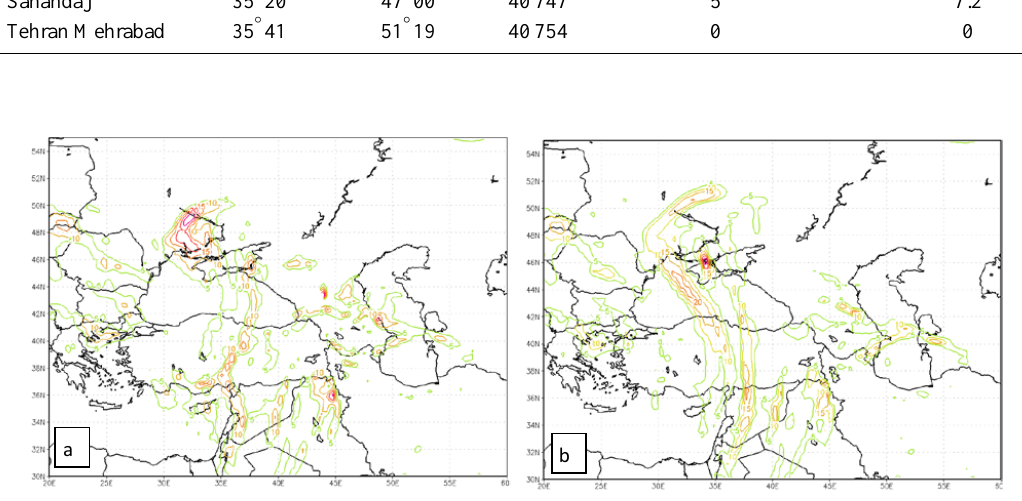
Fig. 5. Forecasts of 700hPa relative vorticity (s − 1 × 10 5 ) for 14 March 2009 at 00:00 UTC for (a) CTL and (b) EXP. Fig.5.Forecasts of 700 hPa relative vorticity ( for (a) CTL and (b) EXP. The 700 hPa relative vorticity forecasts for 00:00 UTC 14 March 2009 for both CTL and EXP are shown in Fig.